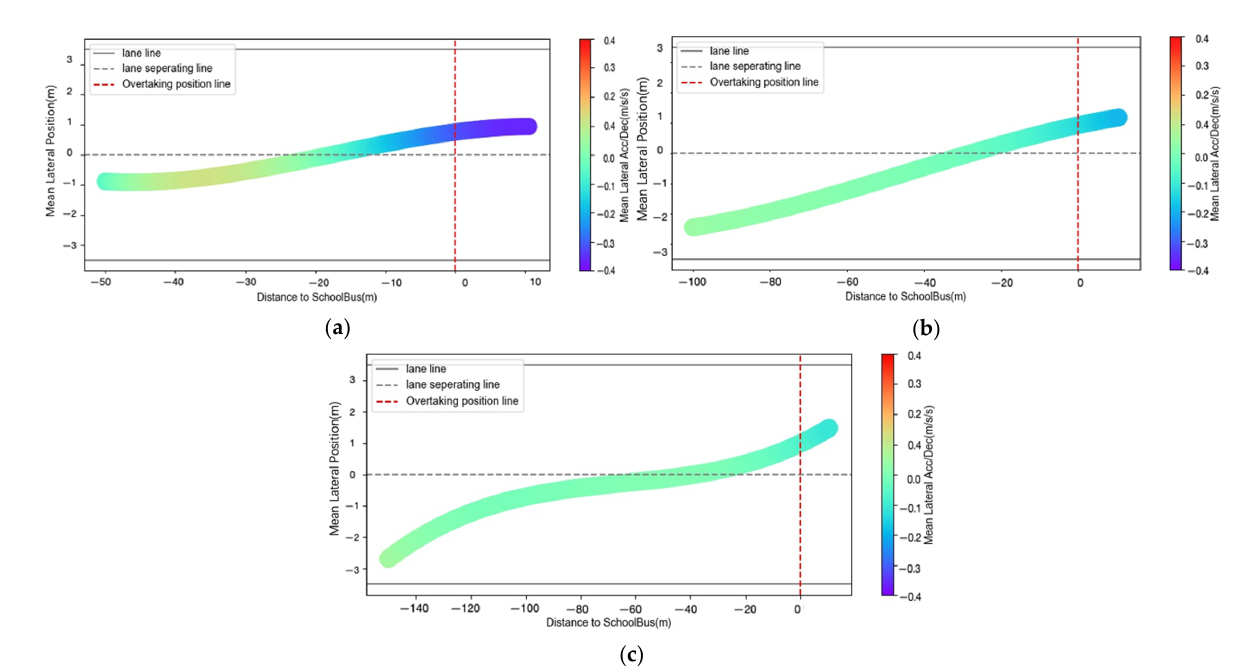
volume and IDCTS, the variation of average lateral acceleration gradually decreases,